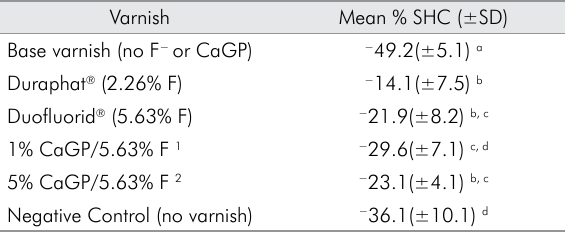
Table 2. Mean (±SD) of the percentage of the surface hardness change